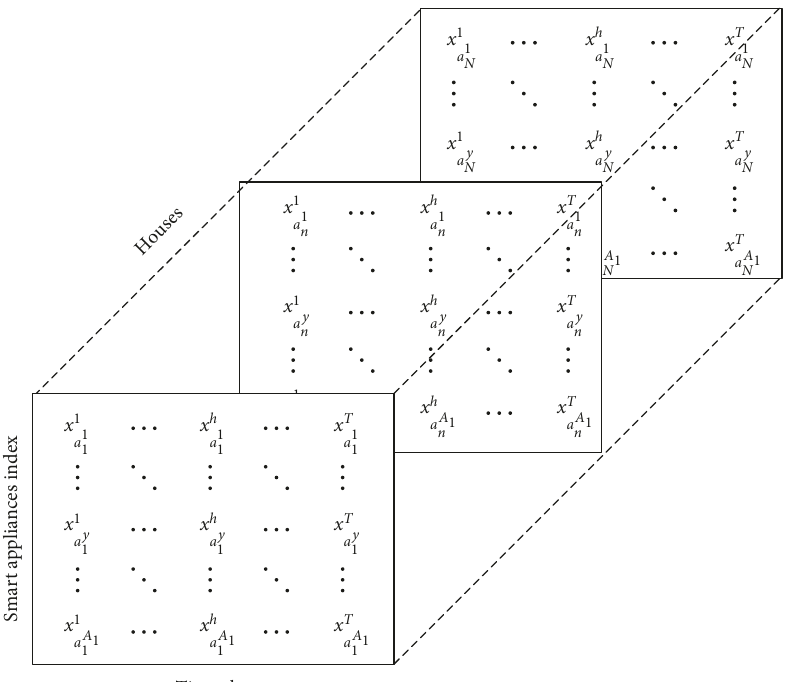
Figure 3: Appliances schedule matrix for the smart community for a